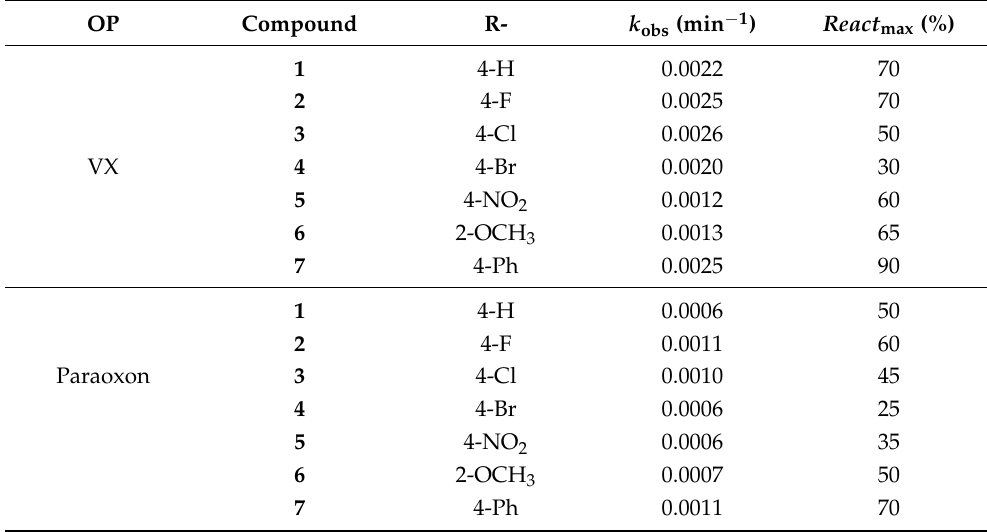
Table 4. Reactivation screening of BChE inhibited by OPs with 1 mM dioximes: first-order reactivation rates, k obs , and maximal reactivation percentage, React max obtained in 24 h. Constants presented as the mean of at least two experiments (standard error was less than 10%, and therefore not indicated).